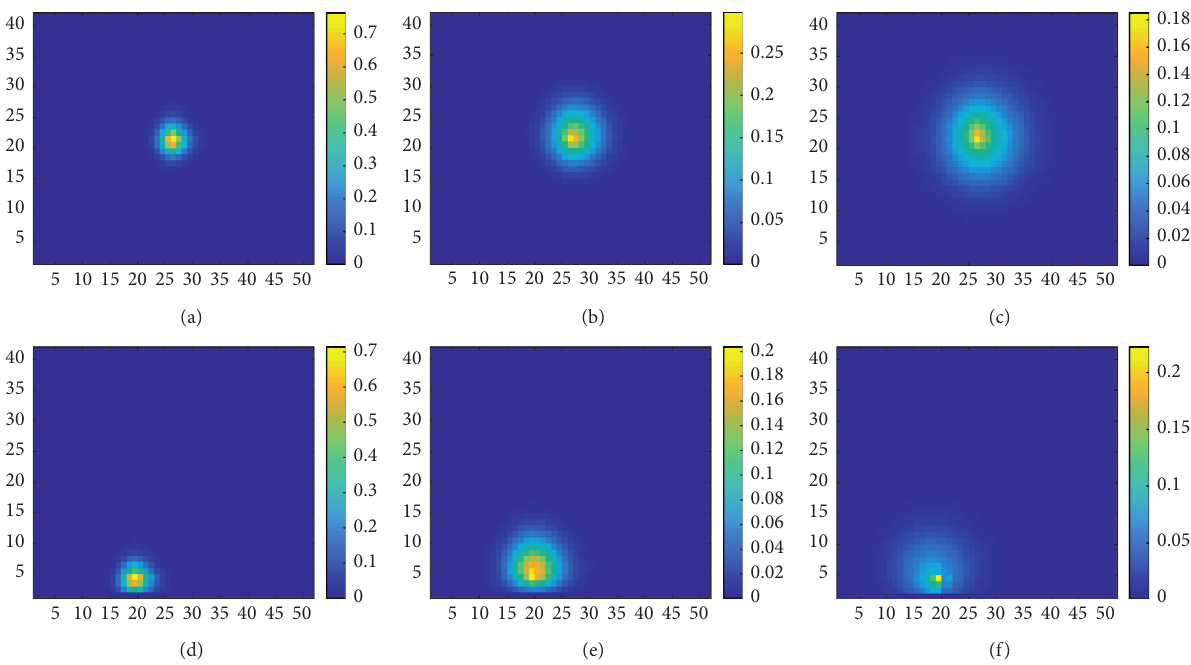
Figure 2: The spread of gaseous hazardous material in scenario ( i ) and scenario ( ii ) at time 5.22s, 15.08s, and 39.15s. The velocity field ,w ) in equation (4) is chosen randomly out of the interval [− 0 . 5 , 0 . 5 ] . (a) t � 5: 22s, (b) t � 15: 08s, (c) t � 39:15s, (d) t � 5 :22s, (e) ( w 1 2 t � 15 :08s, and (f) t � 39:15